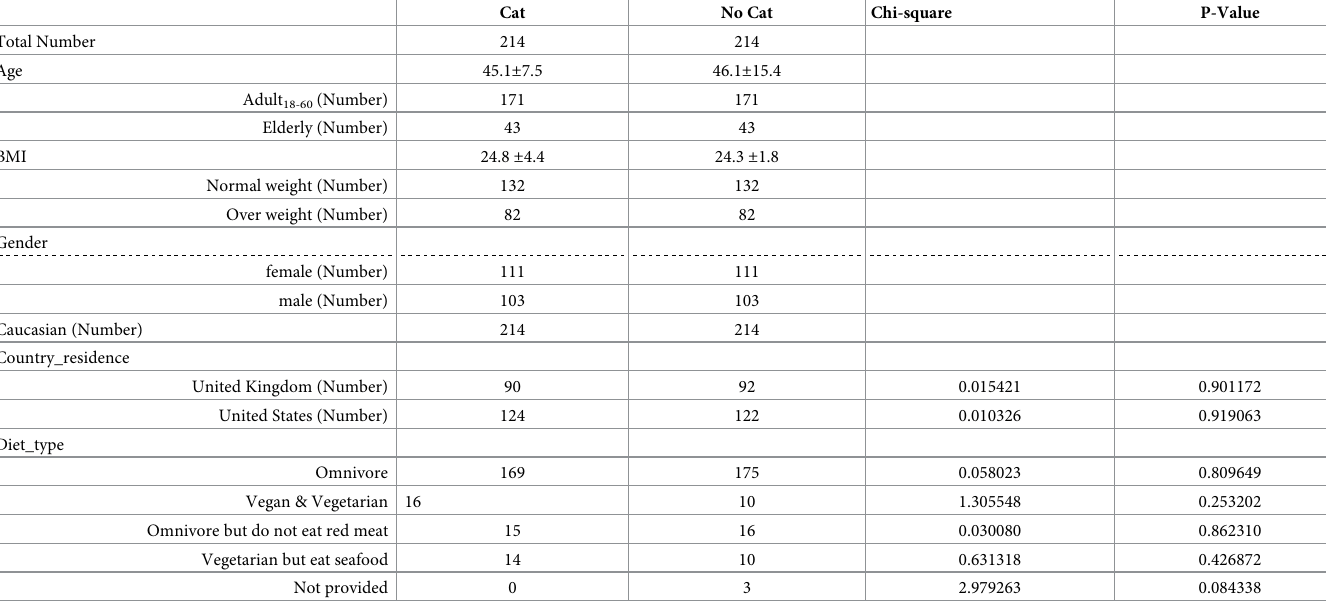
Table 1. Demographic and anthropometric characteristics of the individuals with or without